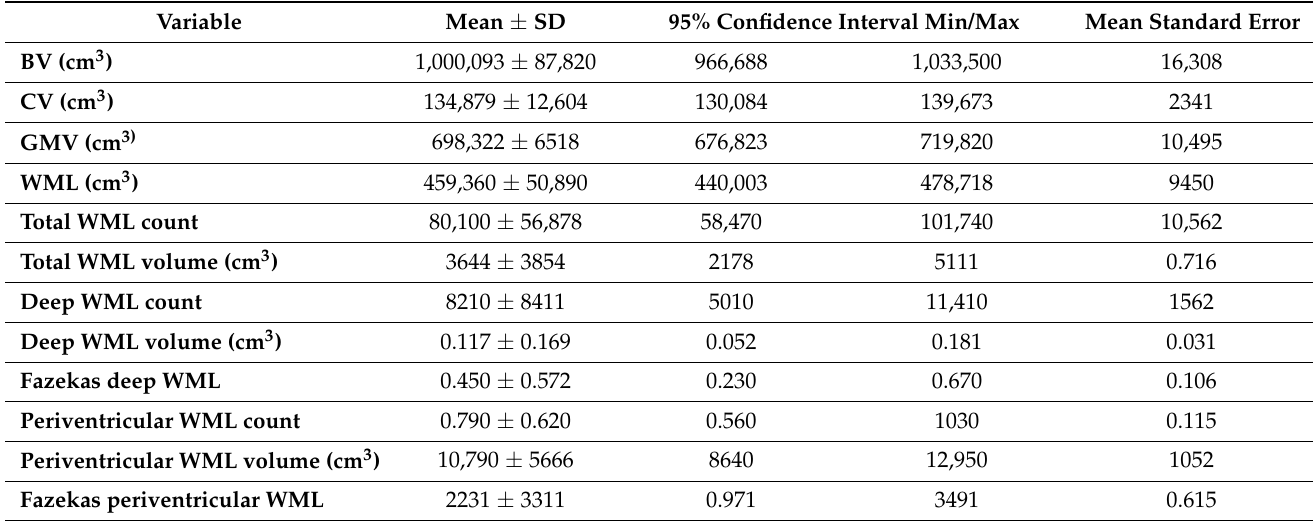
Table 2. The results of MRI parameters in patients with psoriasis. Mean values, standard deviations and significance of differences between groups are shown.